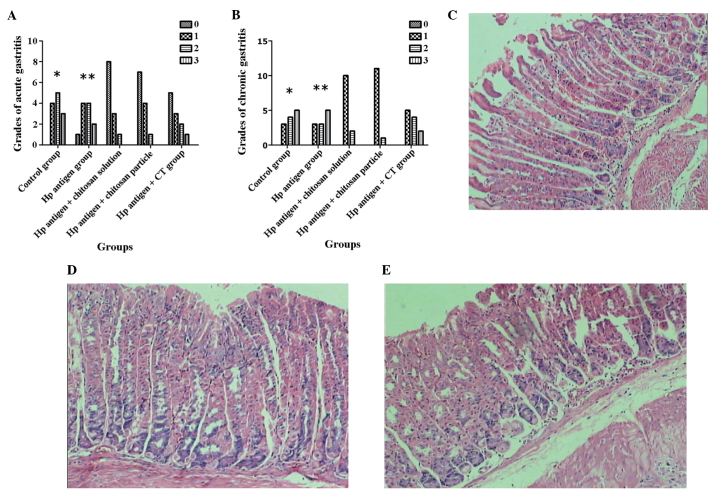
(A) Grade values of acute gastritis. *P<0.001 compared with the Hp antigen + chitosan solution group and the Hp antigen + chitosan particle group; P<0.005 for the control group vs. the Hp antigen + CT group. **P<0.005 compared with the Hp antigen + chitosan solution group and the Hp antigen + chitosan particle group; P<0.05 for the Hp antigen group vs. the Hp antigen + CT group. (B) The grade values of chronic gastritis in the groups with chitosan as the adjuvant were significantly less when compared with those of the groups without chitosan as the adjuvant (P<0.001–0.05). *P<0.001 compared with the Hp antigen + chitosan solution group and the Hp antigen + chitosan particle group. **P<0.05 compared with the Hp antigen + chitosan solution group and the Hp antigen + chitosan particle group. (0, few lymphocyte; 1, sporadic lymphocyte and plasmocyte; 3, more lymphocyte and plasmocyte; 3, large number of lymphocyte and plasmocyte). (C-E) H&E staining of the gastric mucosa (magnification, x100) revealed the following: (C) The control group demonstrated increased inflammatory cell infiltration; (D) the group with chitosan as the adjuvant revealed mild inflammatory cell infiltration; and (E) the group with CT as the adjuvant demonstrated increased inflammatory cell infiltration. Hp, H. pylori; CT, cholera toxin; H&E, hematoxylin and eosin.